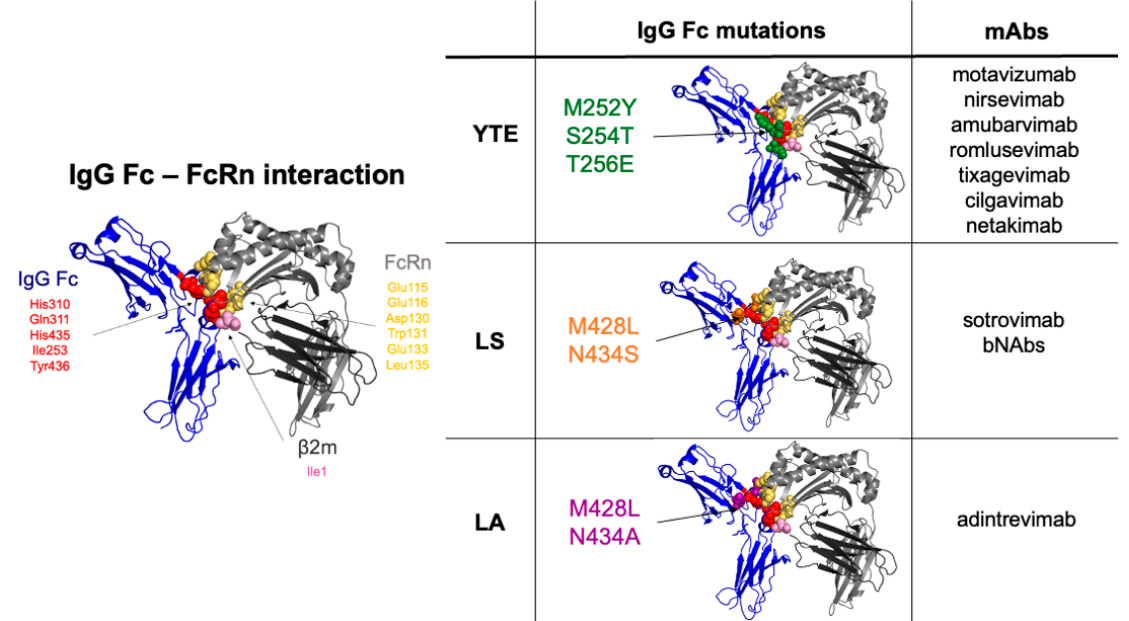
Figure 1. Three-dimensional view of IgG Fc–FcRn interaction and IgG Fc mutations in mAbs. IgG Fc, FcRn ⍺ -chain and β 2-microglobulin are shown in dark blue, grey, and dark grey, respectively. IgG Fc–FcRn interaction is shown in red (IgG Fc), yellow (FcRn) and pink ( β 2-m) spheres. IgG Fc mutations in mAbs are shown as green (YTE), orange (LS) and purple (LA). The figures were made using PyMOL Molecular Graphics System Version 2.5.3 Copyright © (Schrödinger) and the crystal structure data of IgG–Fc in complex with human FcRn (4N0U). mAbs: monoclonal antibody .